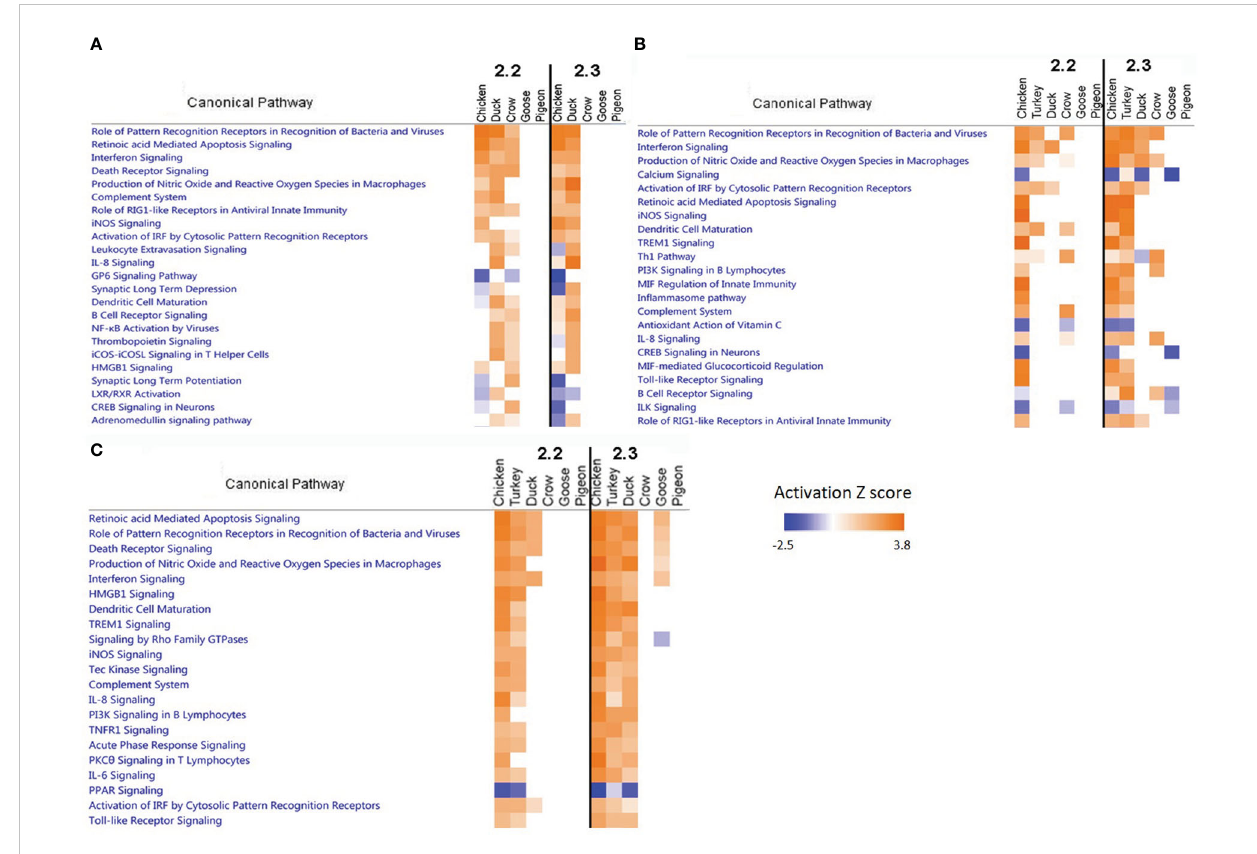
FIGURE 6 Pathway analysis comparison in (A) Lung, (B) Ileum and (C)